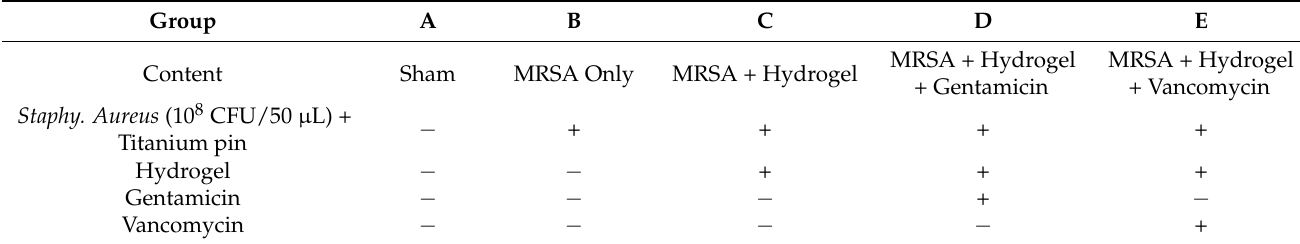
Table 1. Experimental treatment-design of peri-implant osteomyelitis. Group